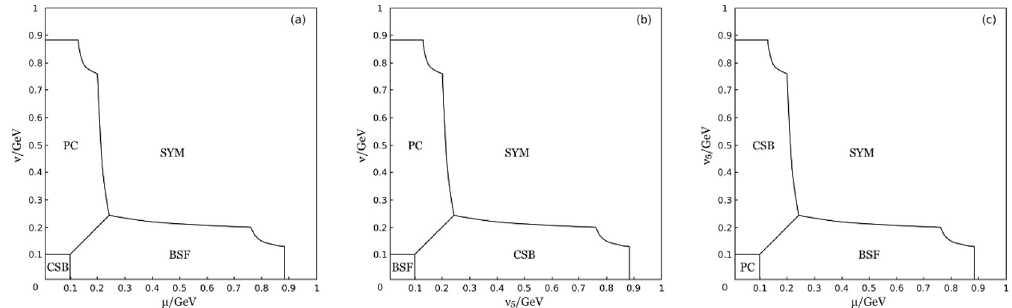
Figure 2 . (a) ( (cid:22); (cid:23) )-phase diagram at (cid:23) 5 = 0 : 1 GeV. (b) ( (cid:23) 5 ; (cid:23) )-phase diagram at (cid:22) = 0 : 1 GeV. (c) ( (cid:22); (cid:23) 5 )-phase diagram at (cid:23) = 0 : 1 GeV. All the notations are the same as in previous (cid:12)gure 1. to the line (cid:22) = (cid:23) (it is one of the conclusions of the papers [11, 16]), i.e. this diagram is a self-dual with respect to D mapping. Then, performing in each point of 1